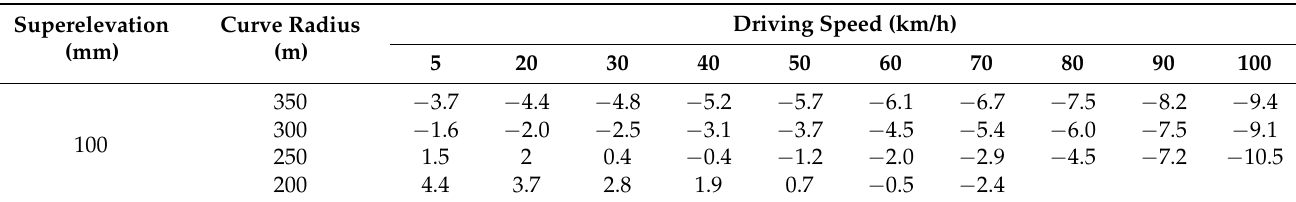
Table 10. Gage widening values in Chinese railways (1954) (mm).